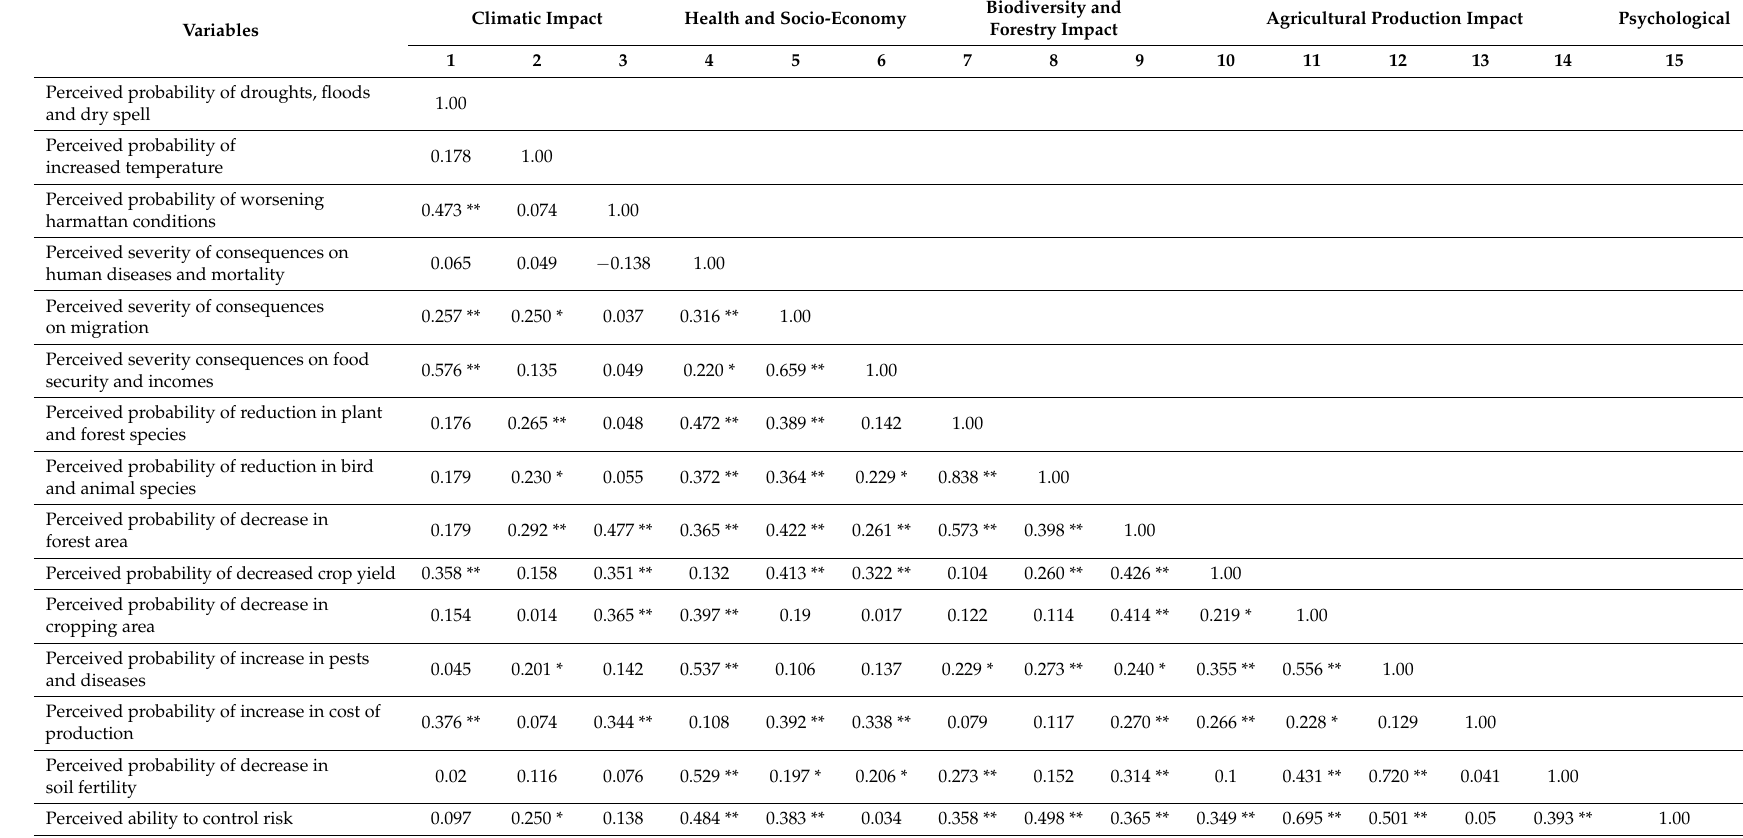
Table 2. Correlations of climate change risk perception variables in the Lawra district of